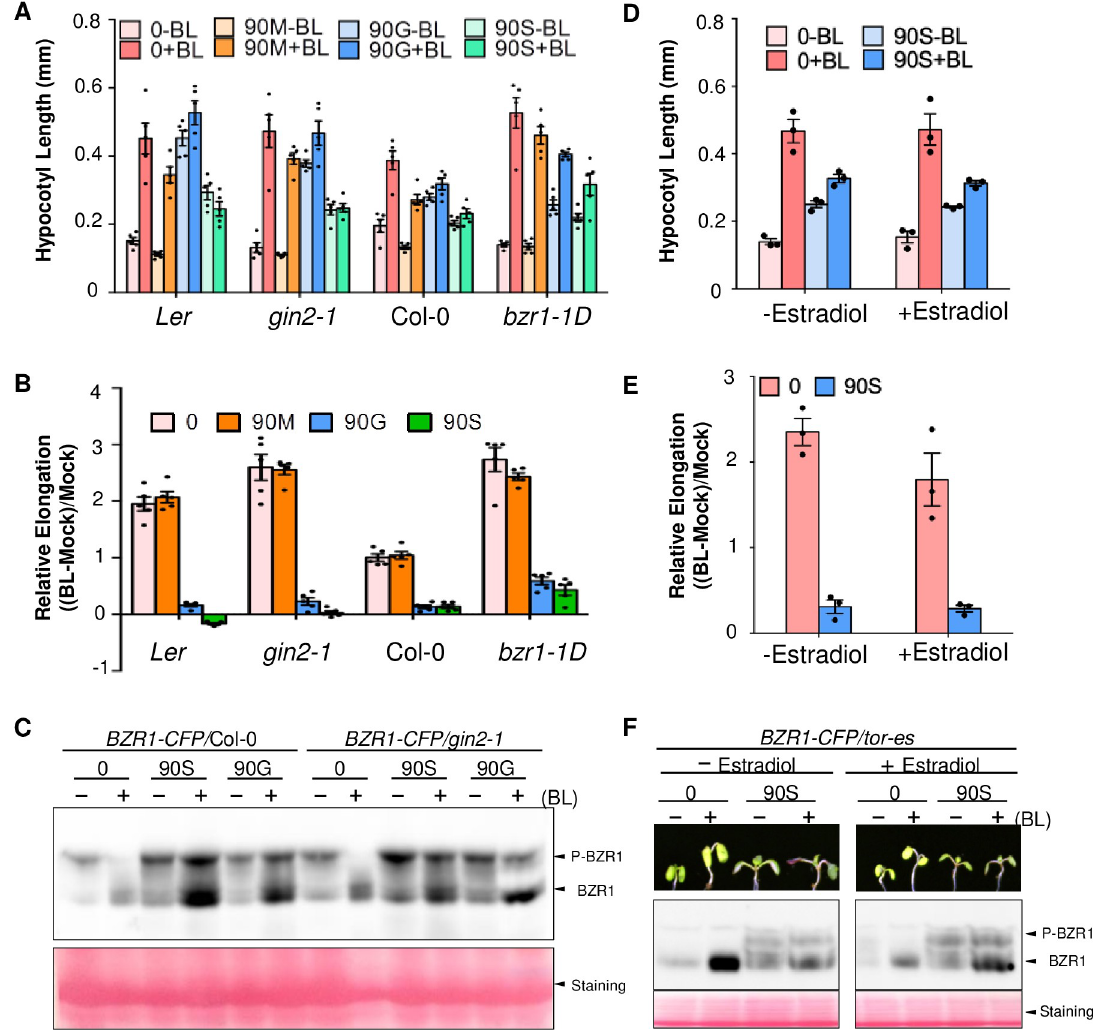
Fig 4. Sucrose inhibits BR signaling independent of HXK1 and TOR. (A) Hypocotyl lengths of seedlings grown on medium containing 0 mM or 90 mM of mannitol (90M), glucose (90G), or sucrose (90S) and no BL (-BL) or 100 nM BL (+BL). (B) Quantitation of BR sensitivity. Relative hypocotyl elongation is calculated as the ratio between the increase of length caused by BR and the length without BR treatment. Error bars indicate the SEM (five independent experiments, n � 20). (C) Immunoblot analysis of BZR1 protein in BZR1-CFP /Col-0 and BZR1-CFP / gin2-1 , grown under conditions as shown in (A). (D) Hypocotyl lengths of tor-es seedlings grown on media containing 0 mM or 90 mM (90S) sucrose, 0 (-BL) or 100 nM BL (+BL), and 0 or 1 μ M estradiol (+Estradiol). (E) Quantitation of BR sensitivity based on data in (D) using the method described for (B). Error bars indicate the SEM (three independent experiments, n � 20). (F) Images of seedlings and immunoblot analysis of BZR1 protein in seedlings described in